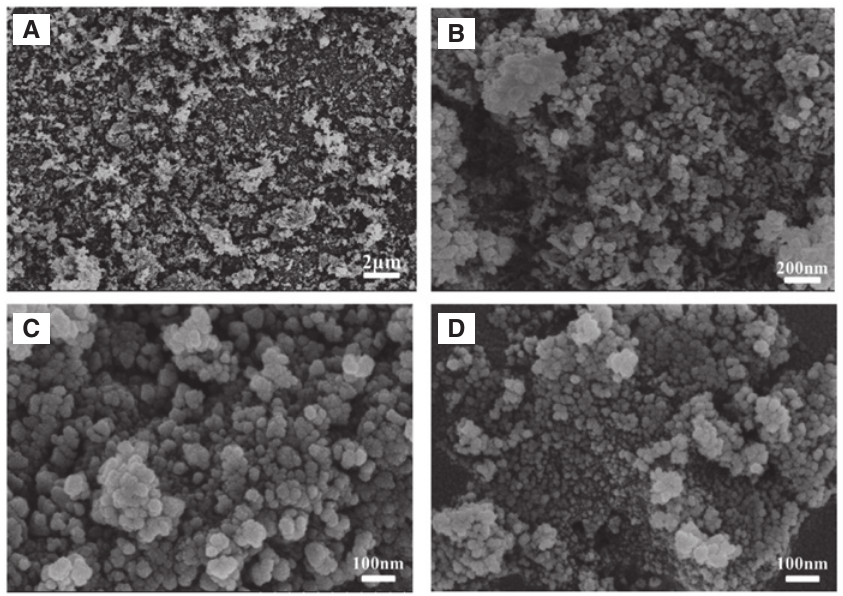
Figure 4: SEM images of the MA + CB0.25 (A), 0.25MA (B), NiO-0MA (C), and NiO-0.25MA